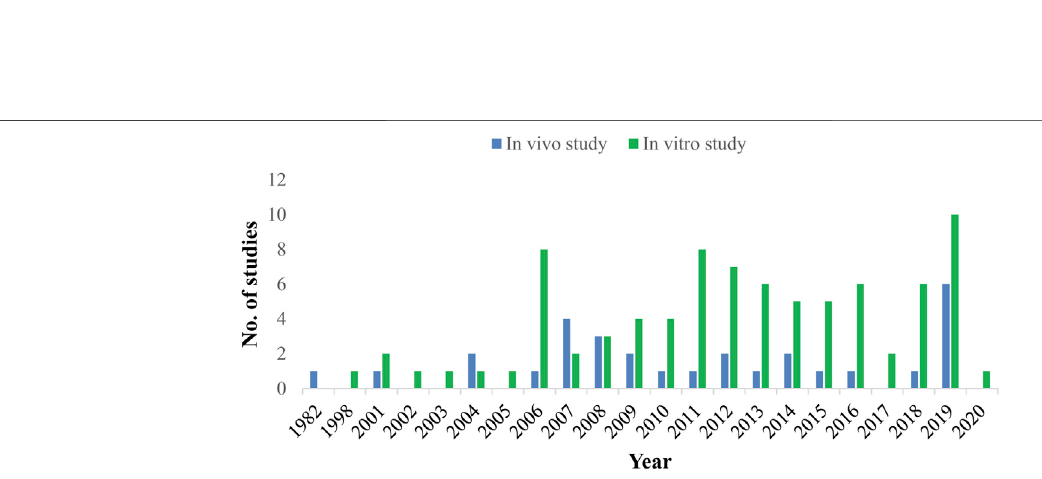
FIGURE 3 | Country-wise comparison of in vitro and in vivo studies.